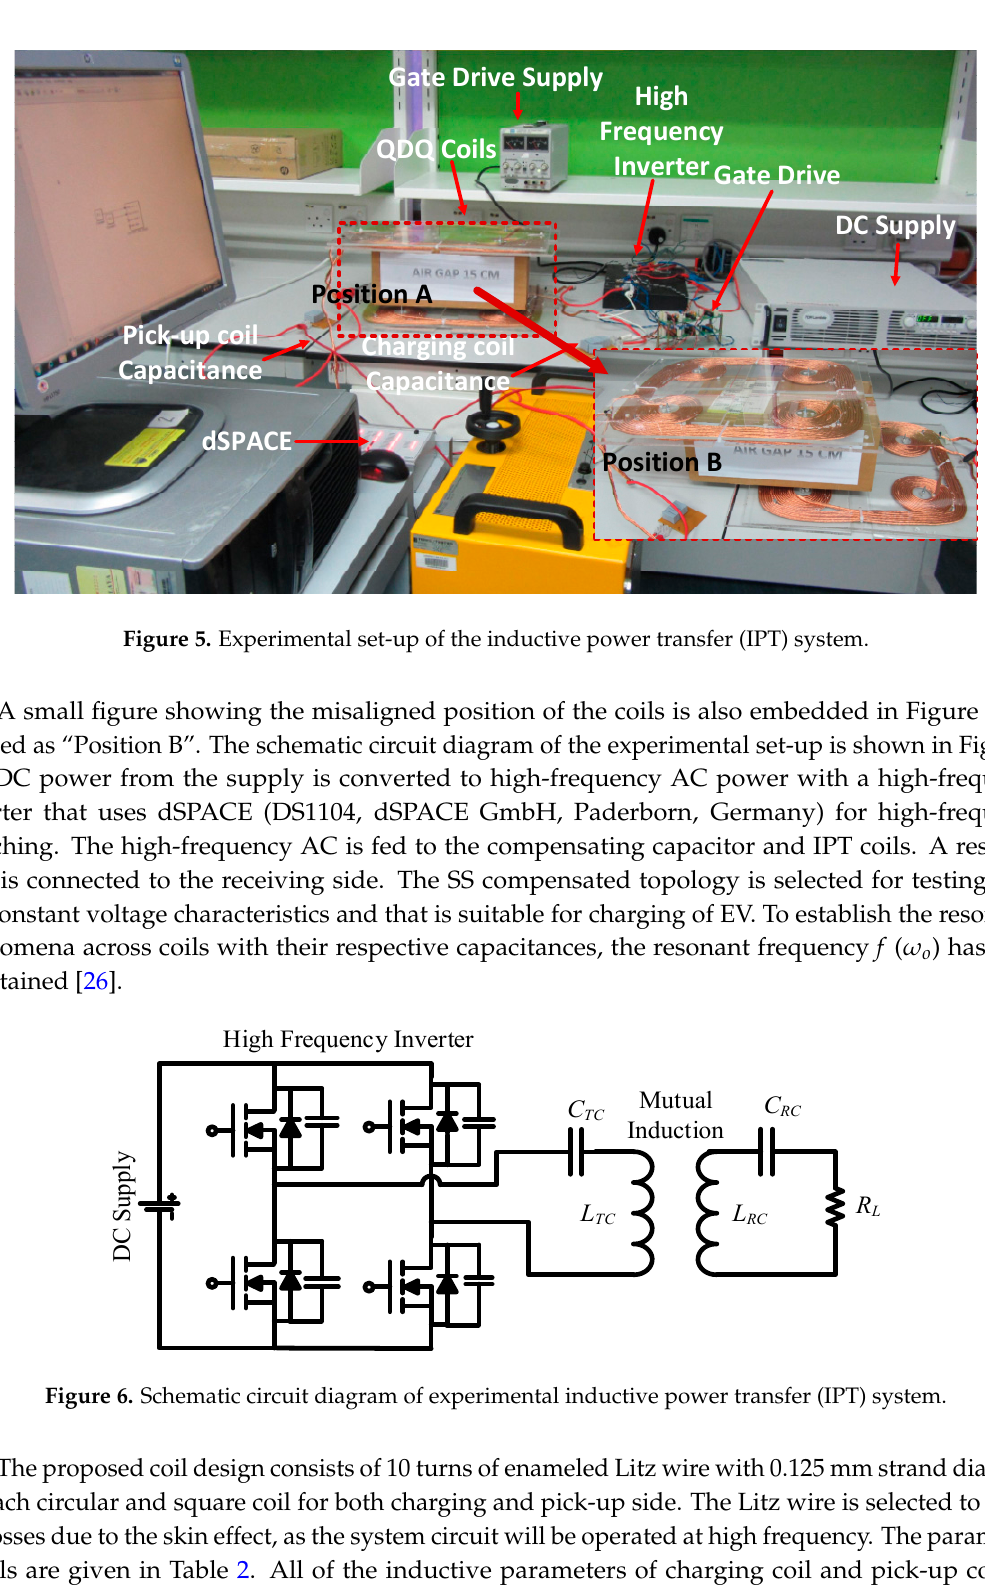
Table 2. Parameters of the inductive power transfer (IPT) system.